Question: Write the caption for this figure.
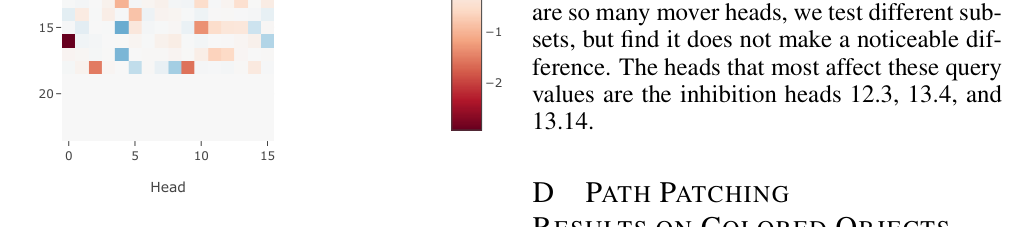
Answer: Path patching to the queries of the neg- ative mover head 19.1. Color bar shows percent logit difference as a result of the patching. This head relies on a different set of heads than the pos- itive mover heads.